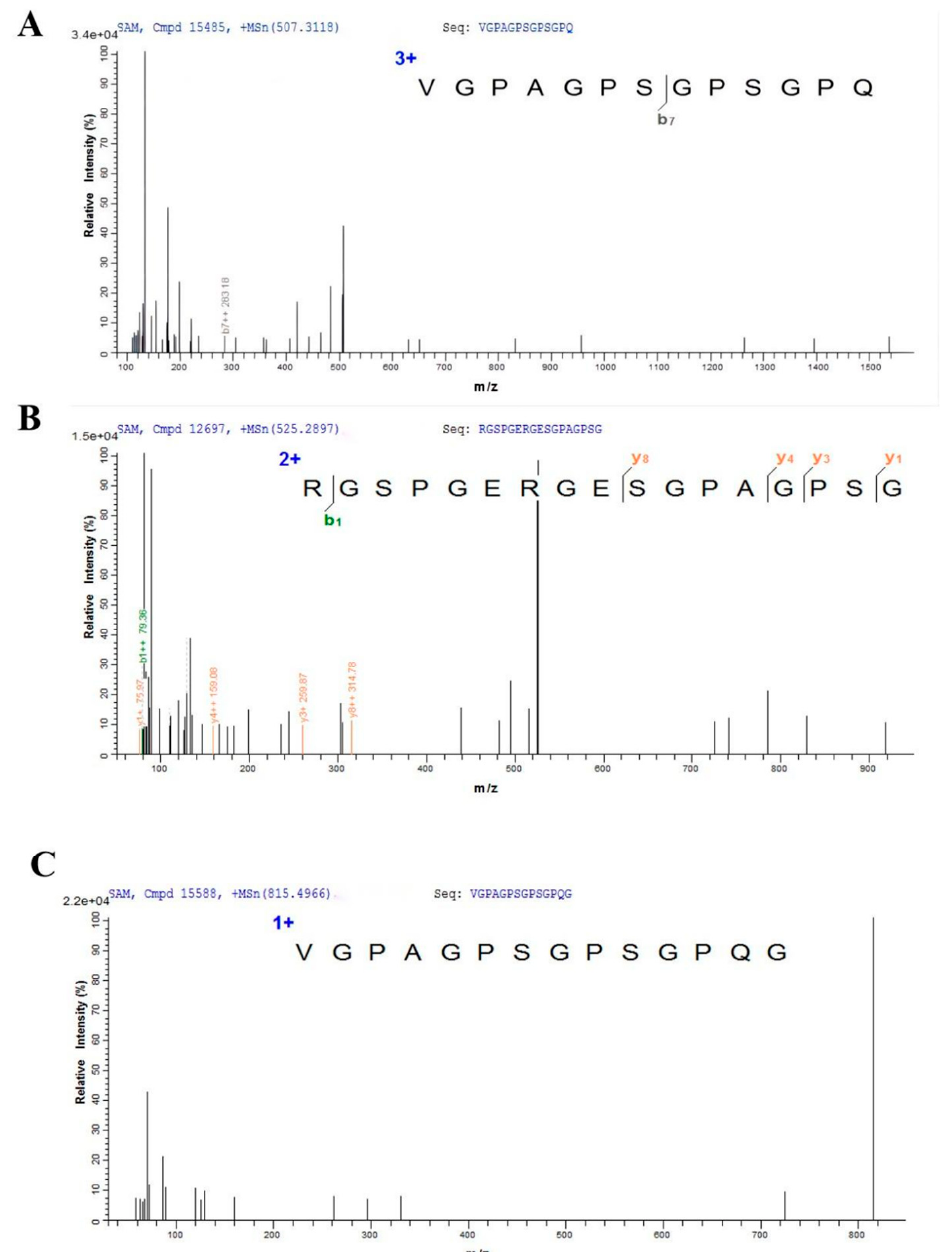
Figure 5. The secondary mass spectrum of GCFSC-AFPs was investigated using Q EXACTIVE LC-MS/MS. As shown in Figure 5, based on electrospray ionization principles, Mascot software, and database scoring, GCFSC-AFPs contained three main peptide amino acids: ( A ): VGPAGPSGPSGPQ, ( B ): RGSPGERGESGPAGPSG, ( C ): VGPAGPSGPSGPQG; the molecular weights of these three peptide of GCFSC-AFPs from the Ctenopharyngodon idella scales were 1107.54 Da, 1164.32 Da, and 1554.72 Da, respectively.